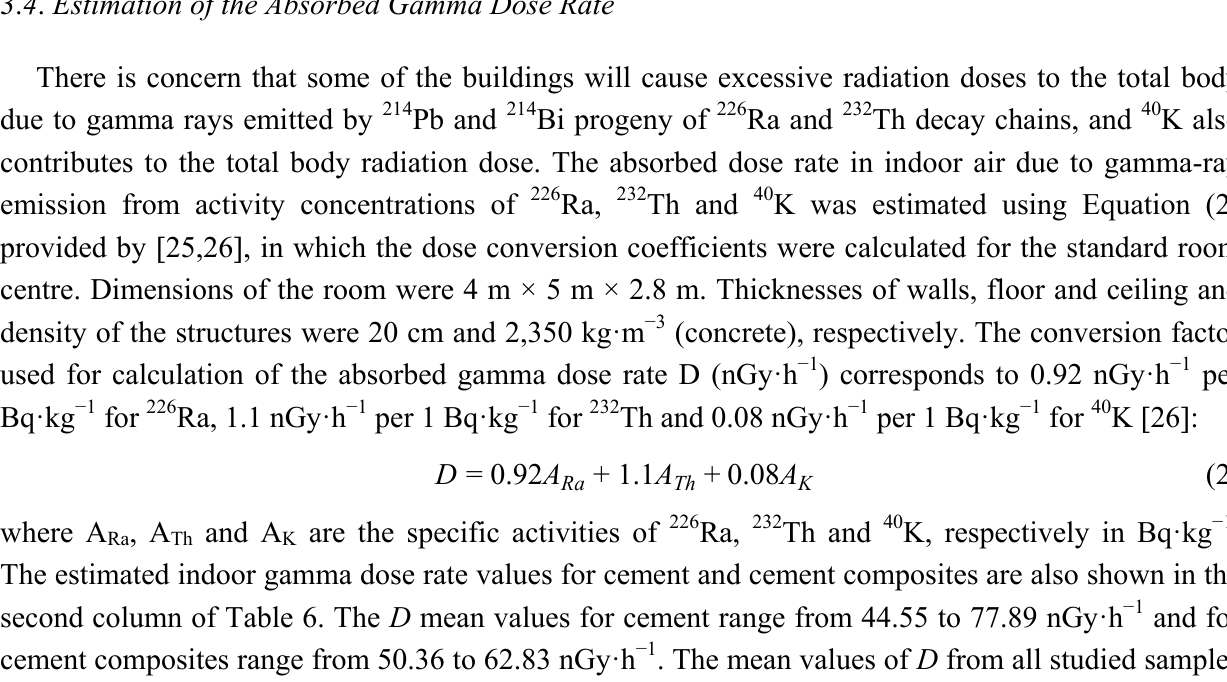
and absorbent eq